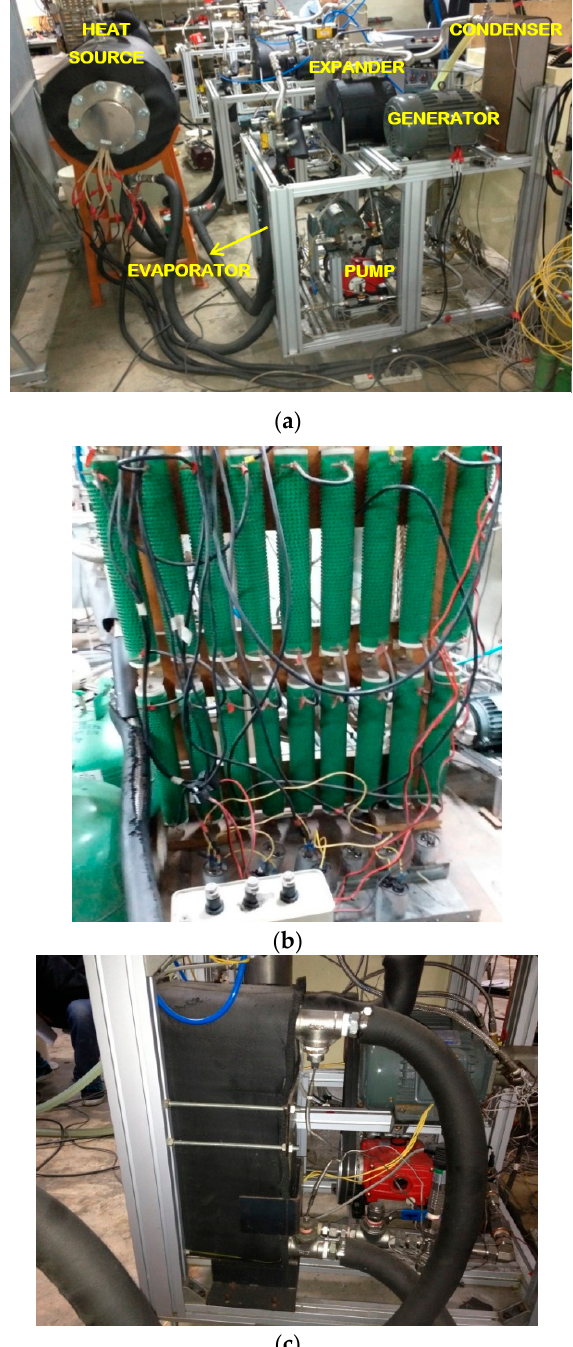
Figure 4. Experiment apparatus layout: ( a ) experimental set up; ( b ) electrical load; and ( c ) evaporator.